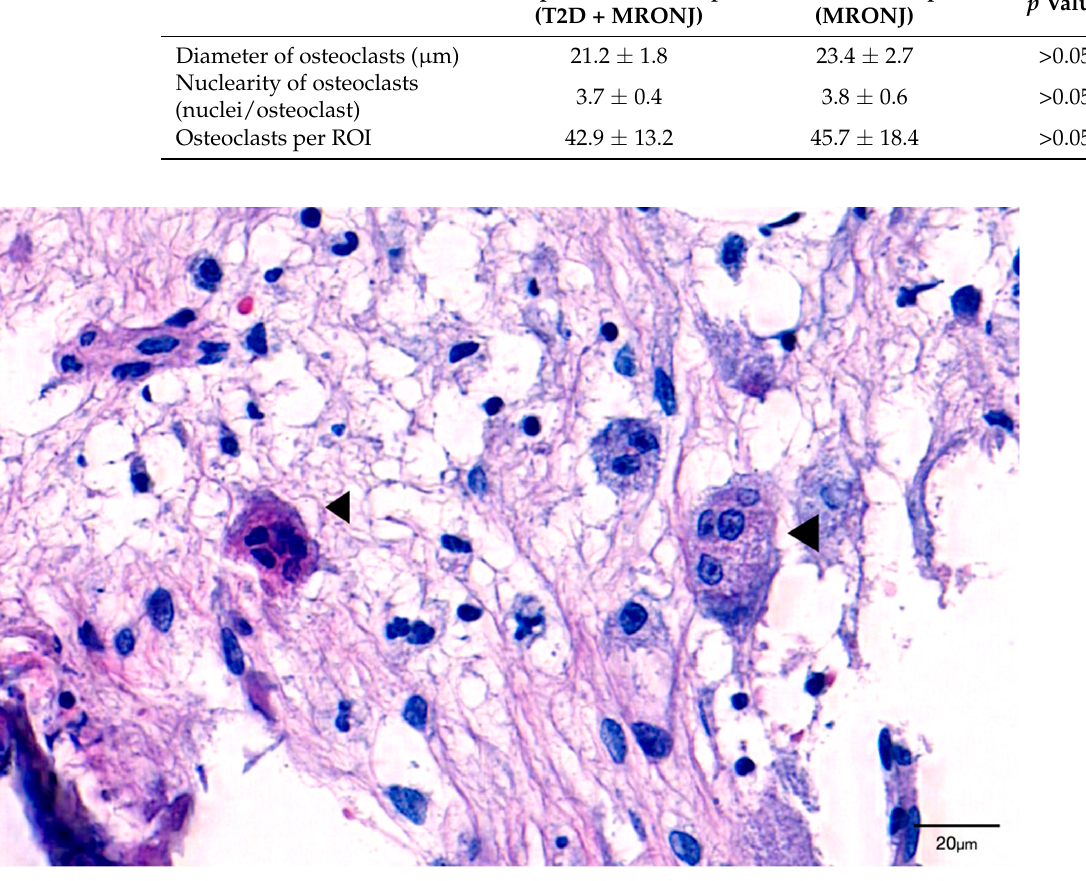
Figure 3. Giant hyper-nucleated osteoclast (arrowhead) within a MRONJ histological section (H&E staining). Note the pyknotic nuclei, round shape, detachment from the bone surface, and lack of ruffled borders.